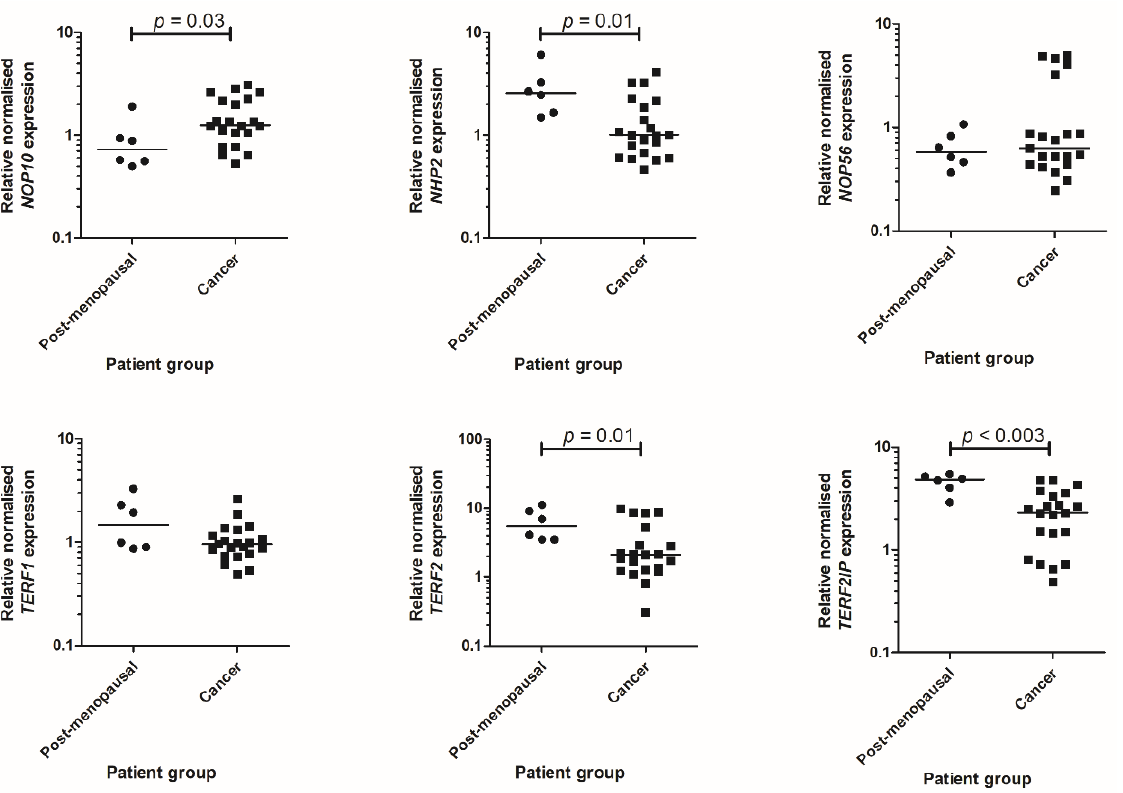
Figure 2. qPCR data for selected telomere and telomerase associated transcripts NOP10 , NHP2 , NOP56 , TERF1 , TERF2 and TERF2IP . Individual points shown are the mean of technical triplicates, with the median indicated by the line. Post-menopausal, n = 6; Cancer, n = 21 for all genes examined.